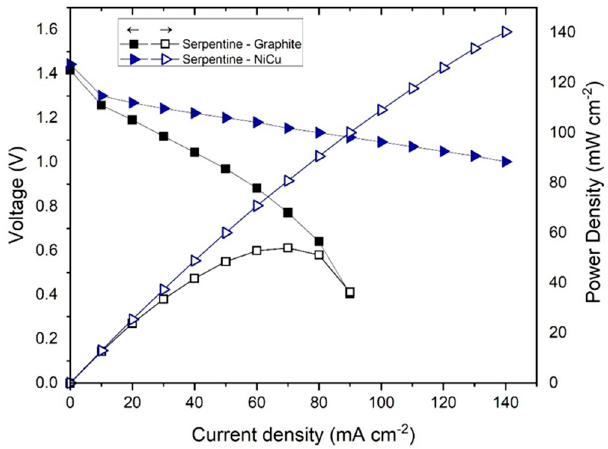
Figure 6. Comparison of the polarization (solid symbols) and power (open symbols) curves of the two serpentine flow fields with different materials.